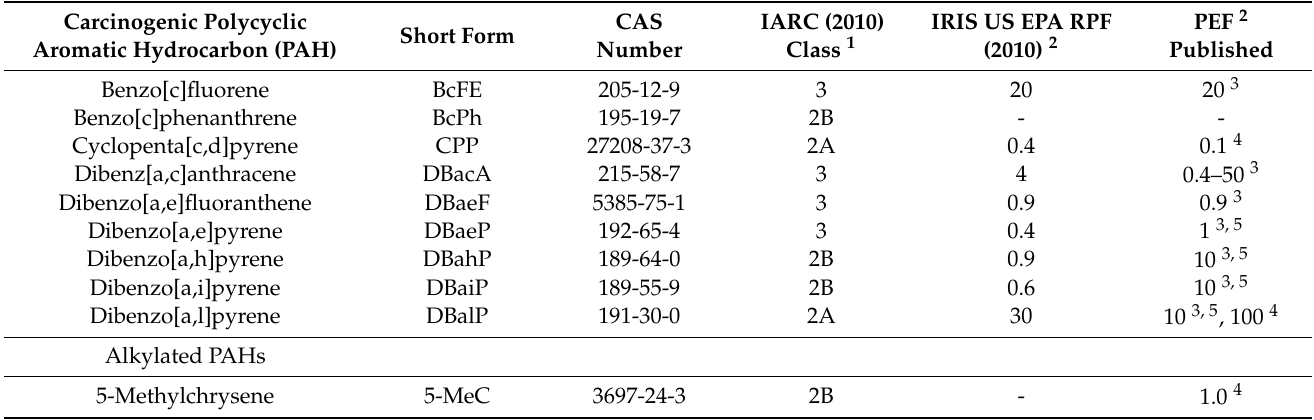
Table 2. Potency Factors of Additional Polycyclic Aromatic Hydrocarbon (PAH) Examined in This Study.